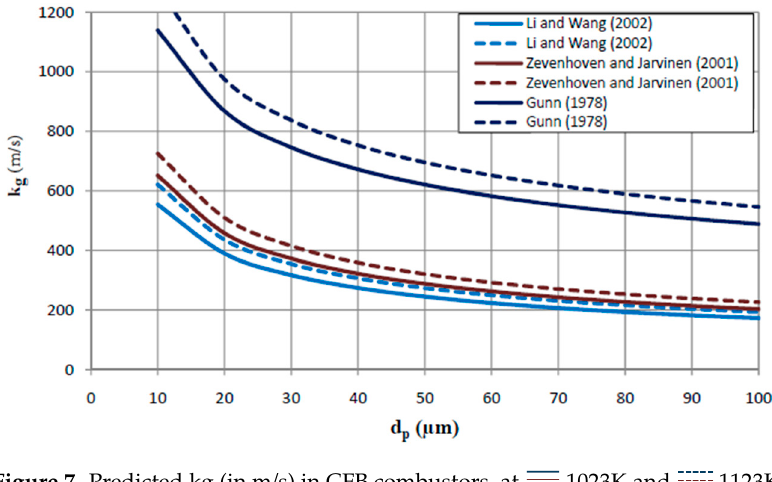
Figure 7. Predicted kg (in m / s) in CFB combustors, at 1023K and 1123K.